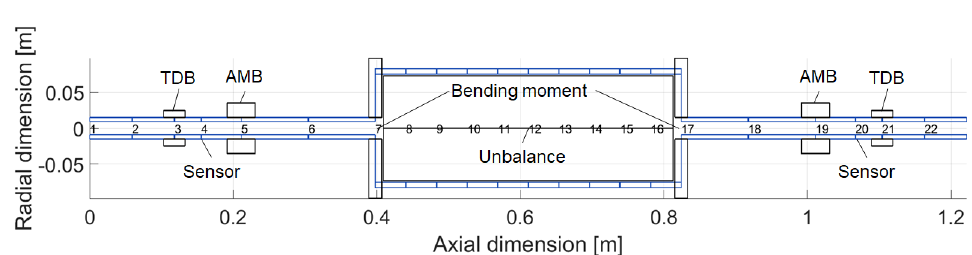
Figure 2. Finite element rotor decomposition into 22 Timoshenko elements and 23